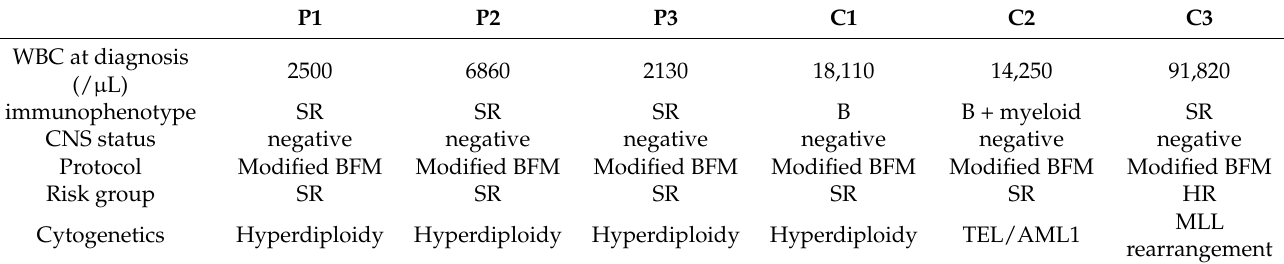
Table 2. Data on acute lymphoblastic leukemia diagnosis and treatment